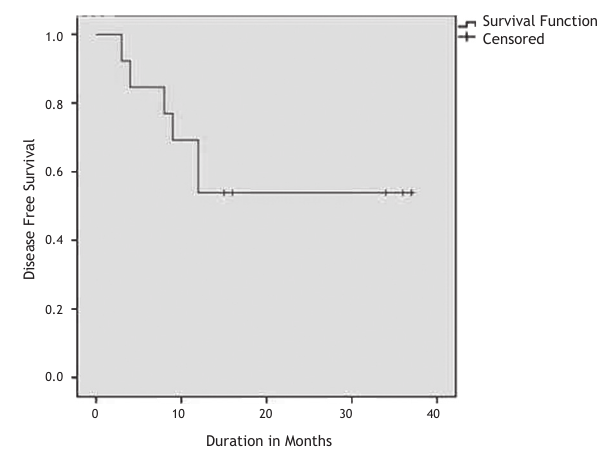
Figure 2 Kaplan Meier survival curve showing disease-free survival for 13